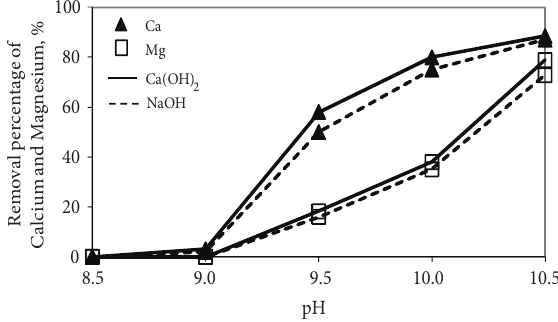
Figure 9. Effect of the type of alkalizing reagent: Ca(OH) 2 or NaOH on the effectiveness of removing calcium and magnesium from the water in the sedimentation